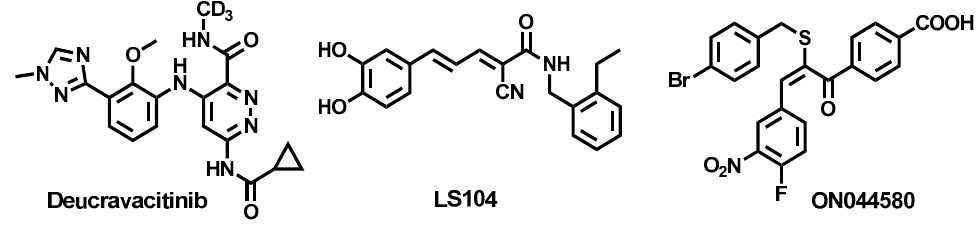
Figure 5. Allosteric JAKs